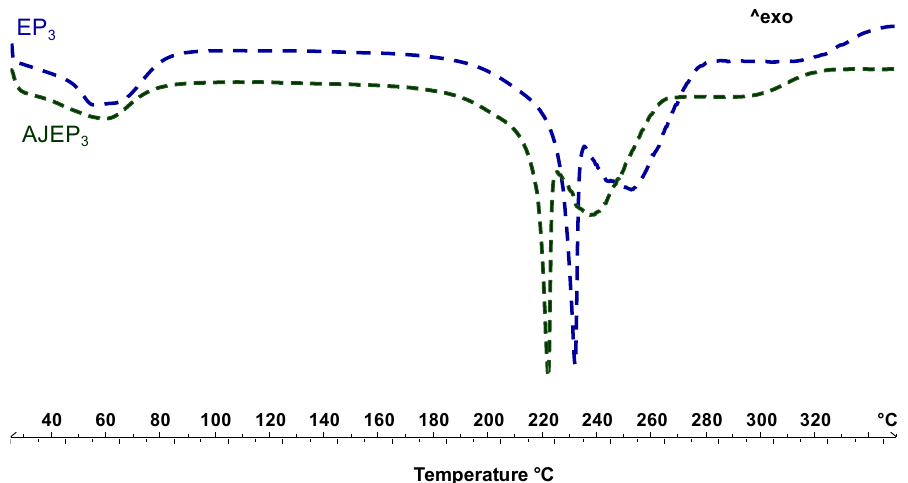
Figure 7. Differential scanning calorimetry (DSC) of blank (EP 3 , blue line) and loaded powder (AJEP 3, green line) at t 0 .